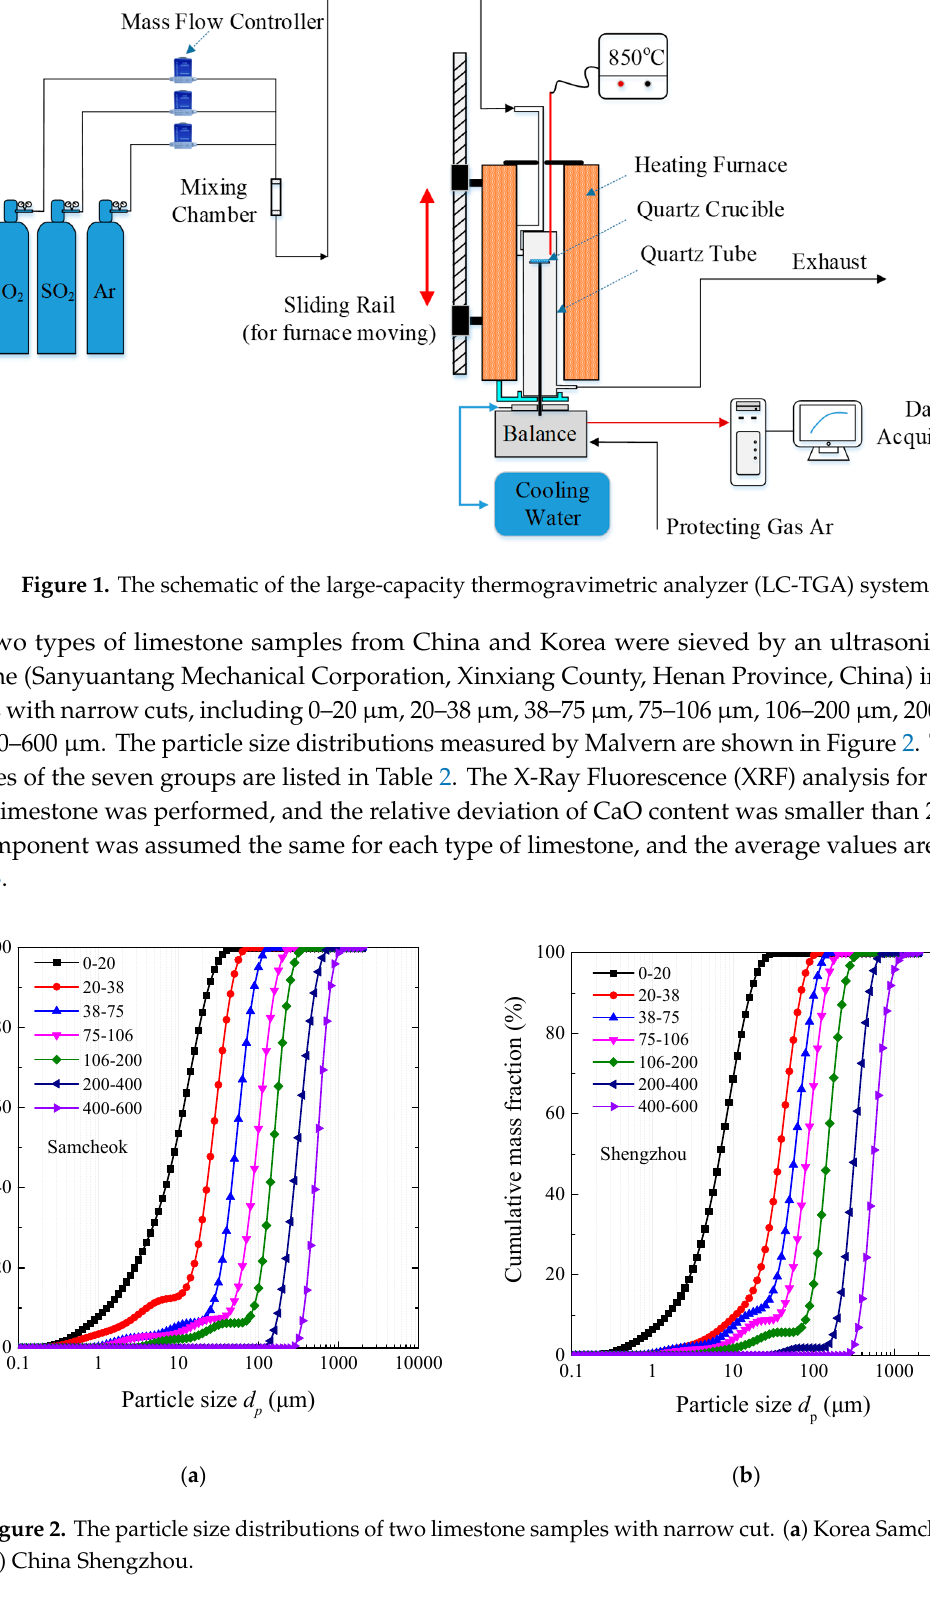
Figure 2. The particle size distributions of two limestone samples with narrow cut. ( a ) Korea Samcheok; ( b ) China Shengzhou.